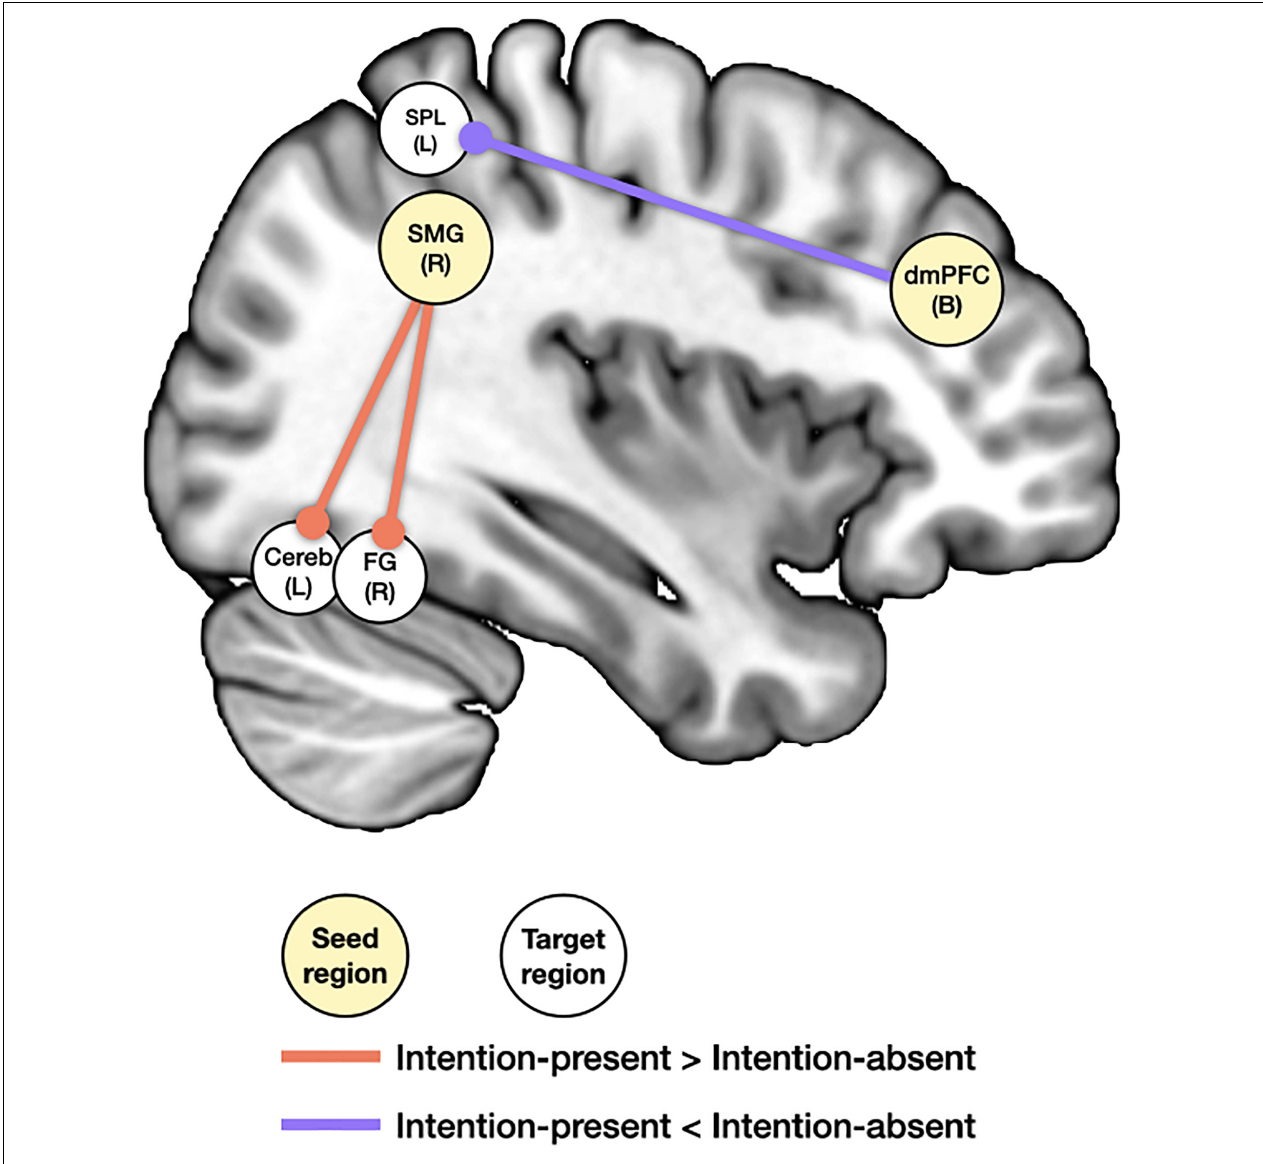
FIGURE 5 | An illustration of psychophysiological interaction effects between purchase intention and product presentation type. The coordinates of seed regions were obtained from peak clusters of mass univariate analysis. L, left; R, right; B, bilateral; SMG, supramarginal gyrus; FG, fusiform gyrus; Cereb, cerebellum; dmPFC, dorsomedial prefrontal cortex; SPL, superior parietal